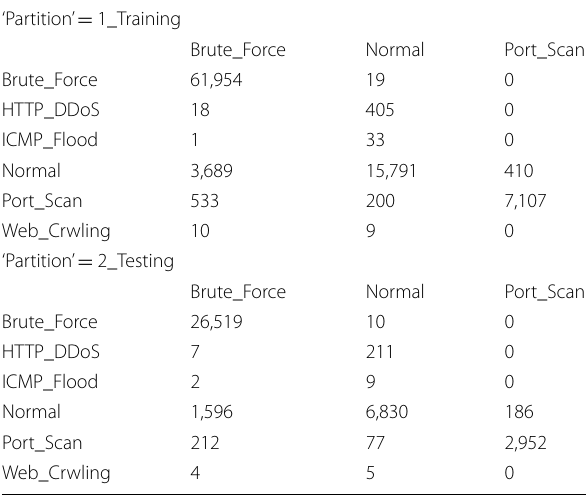
Table 3 Confidence matrix for quest